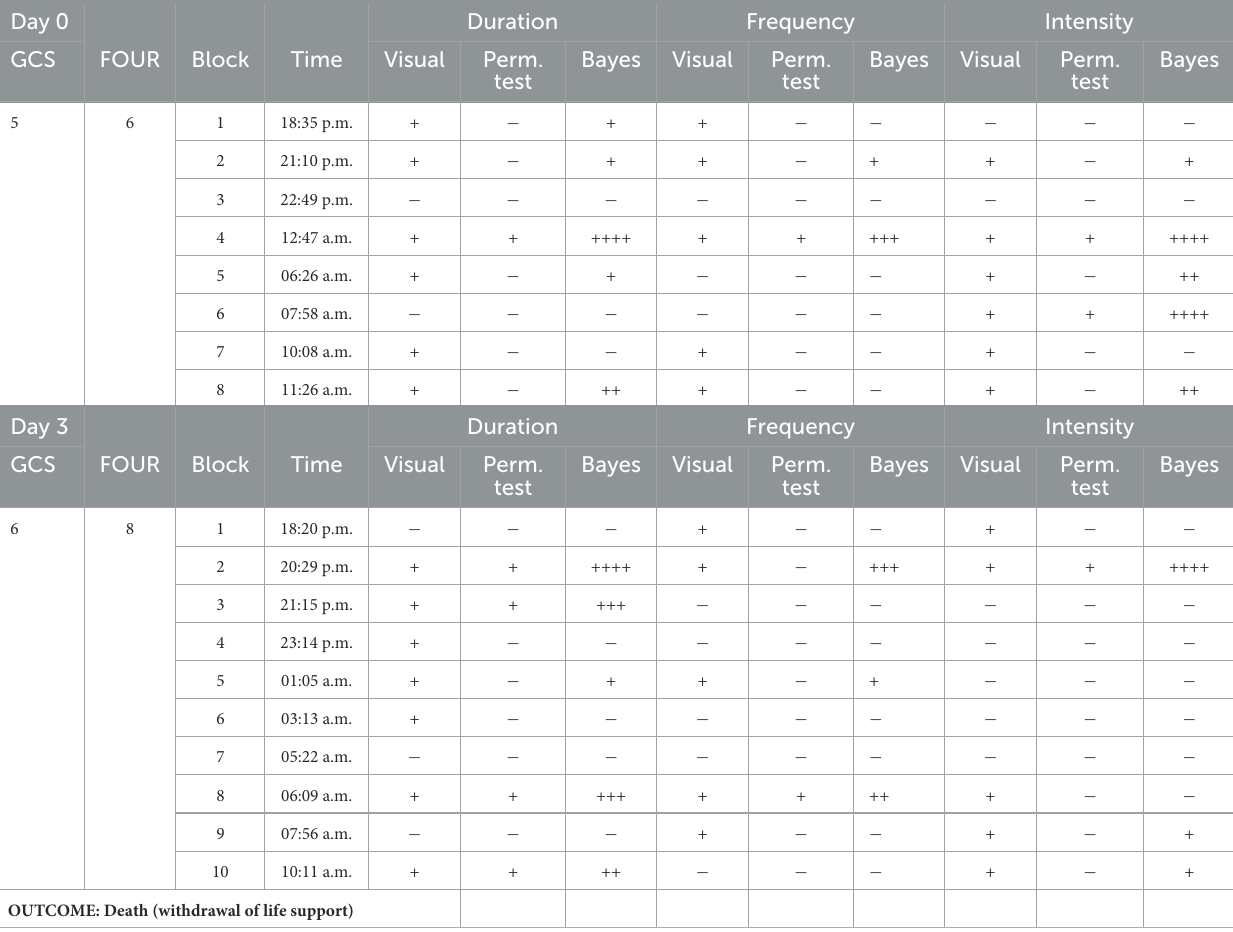
Bayes Visual Perm. Bayes Visual Perm. Bayes test test test